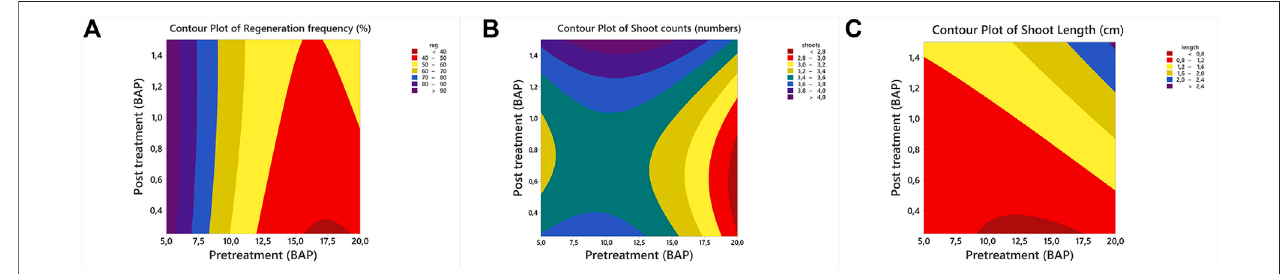
FIGURE 3 | Contour plots of in vitro regeneration of common bean (A) regeneration, (B) shoot count, and (C) shoot length.